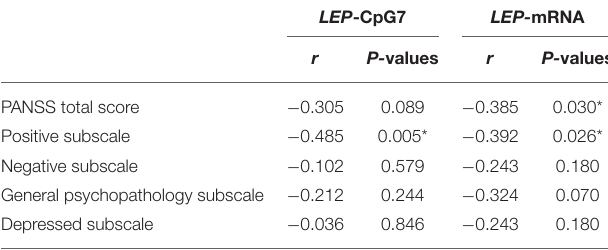
TABLE 2 | Partial correlations between LEP -CpG methylation, LEP -mRNA expression and PANSS scores in patients with schizophrenia, controlled for gender, age, BMI, dose of antipsychotic, and duration of illness ( n = 40).